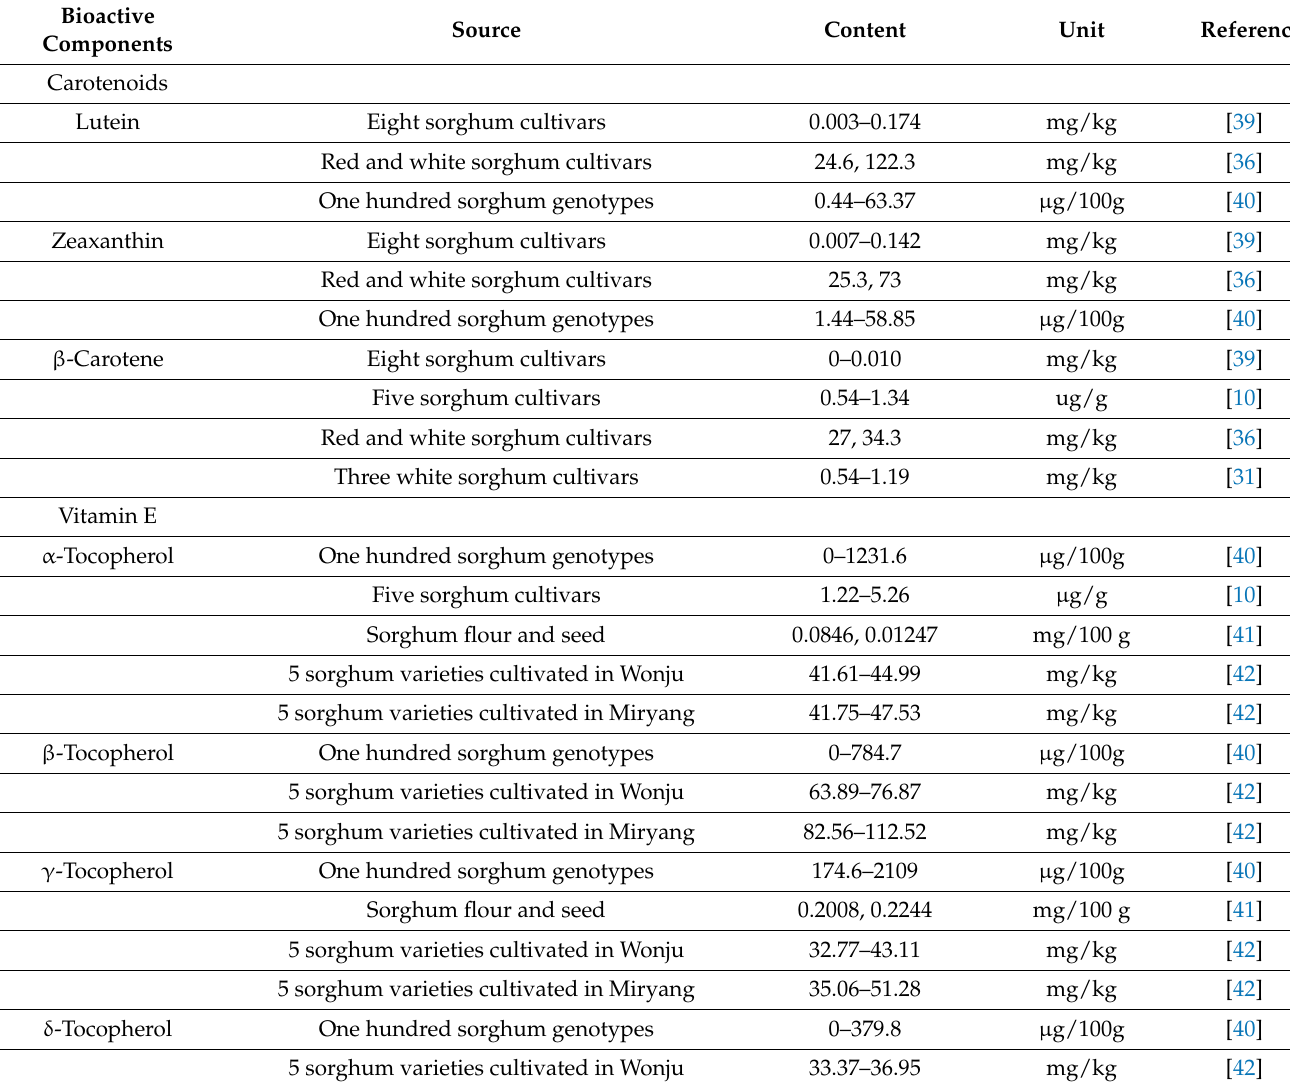
Table 3. Carotenoids, vitamin E, amines, and phytosterols in sorghum